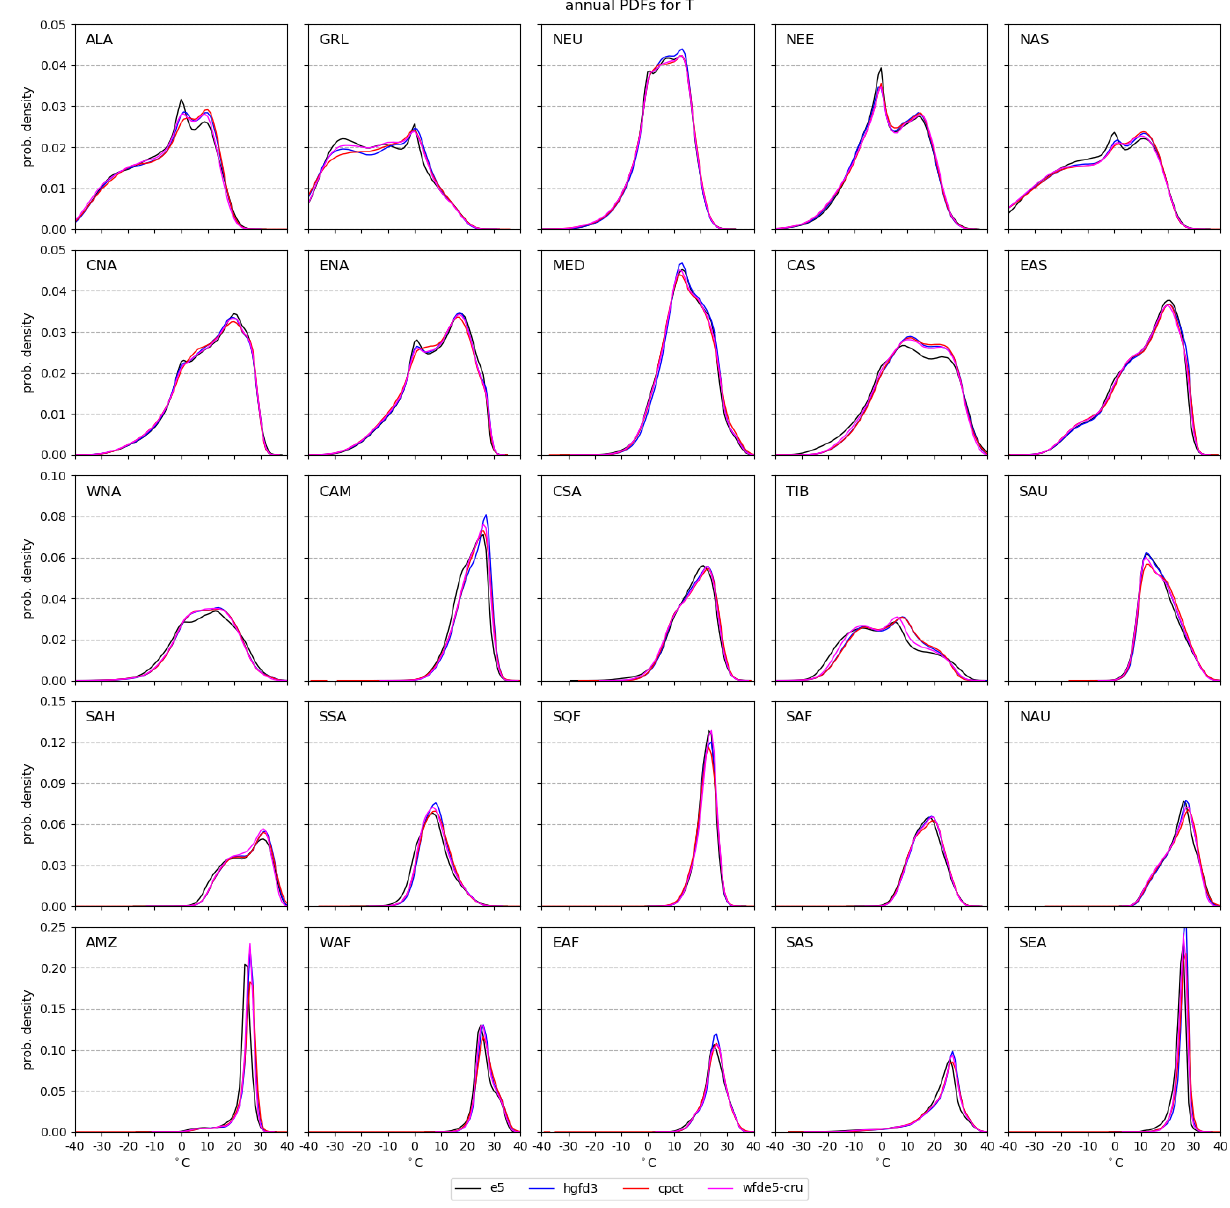
Figure 8. T PDFs of each Giorgi region for the data sets with daily output data in the period 1980–2009.